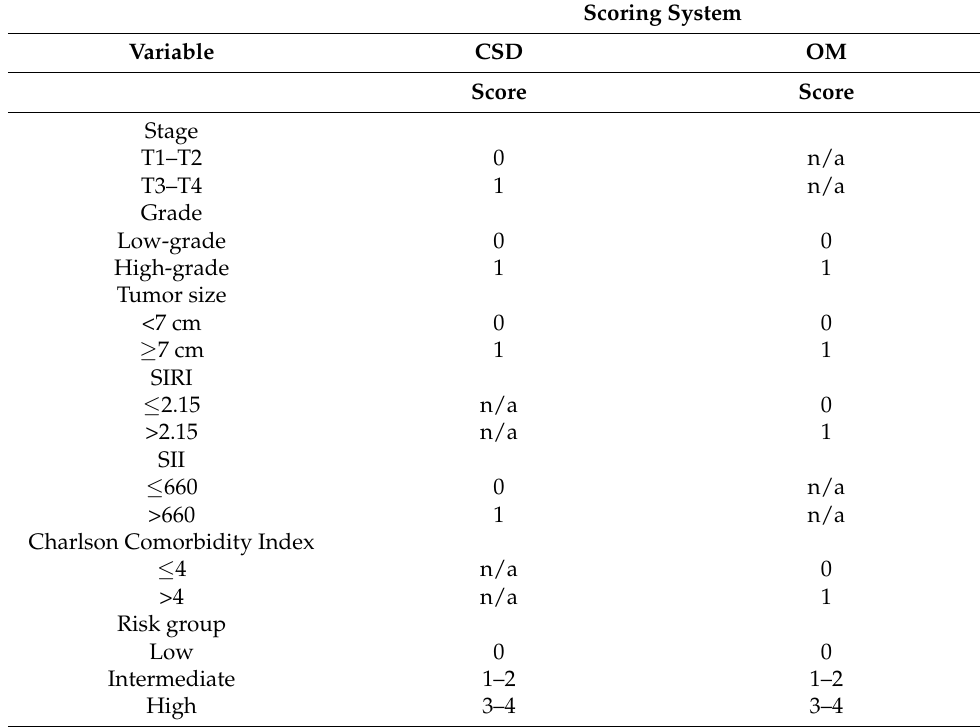
Table 7. Scoring system for the risk of cancer-specific death (CSD) and overall mortality (OM) after surgical treatment of clear cell renal cell carcinoma. n/a—not applicable.